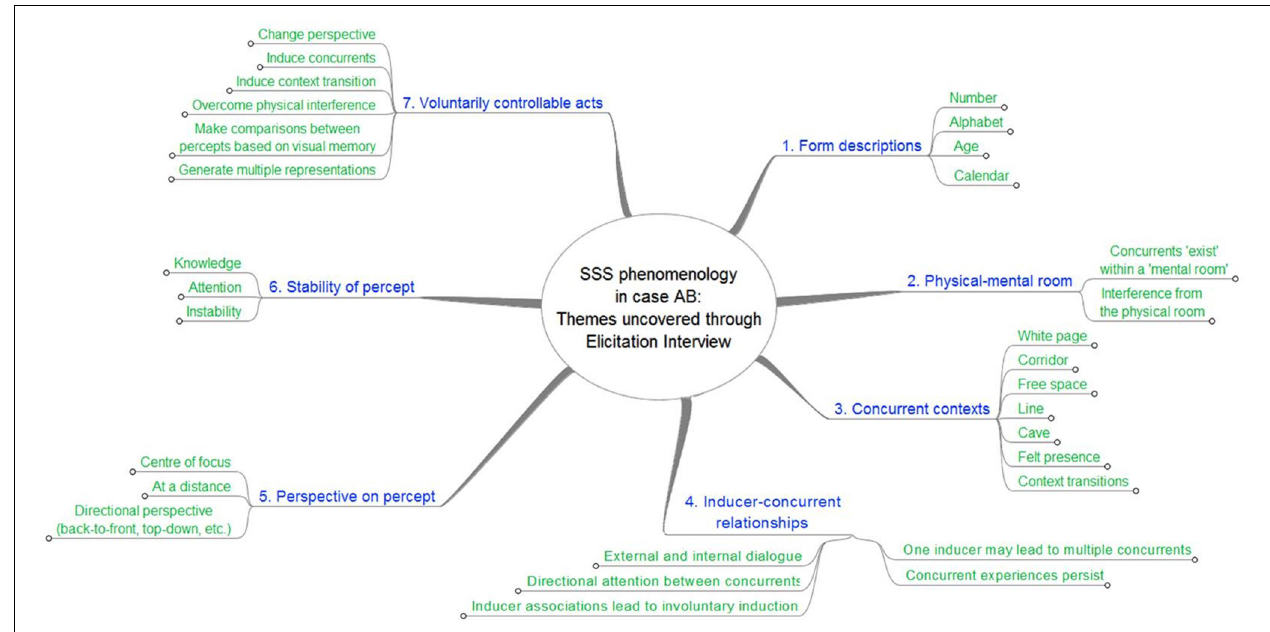
FIGURE 4 | Mind map of content, themes and sub-themes derived from the EI data with case AB. This map is reproduced in the Supplementary Material, where summary